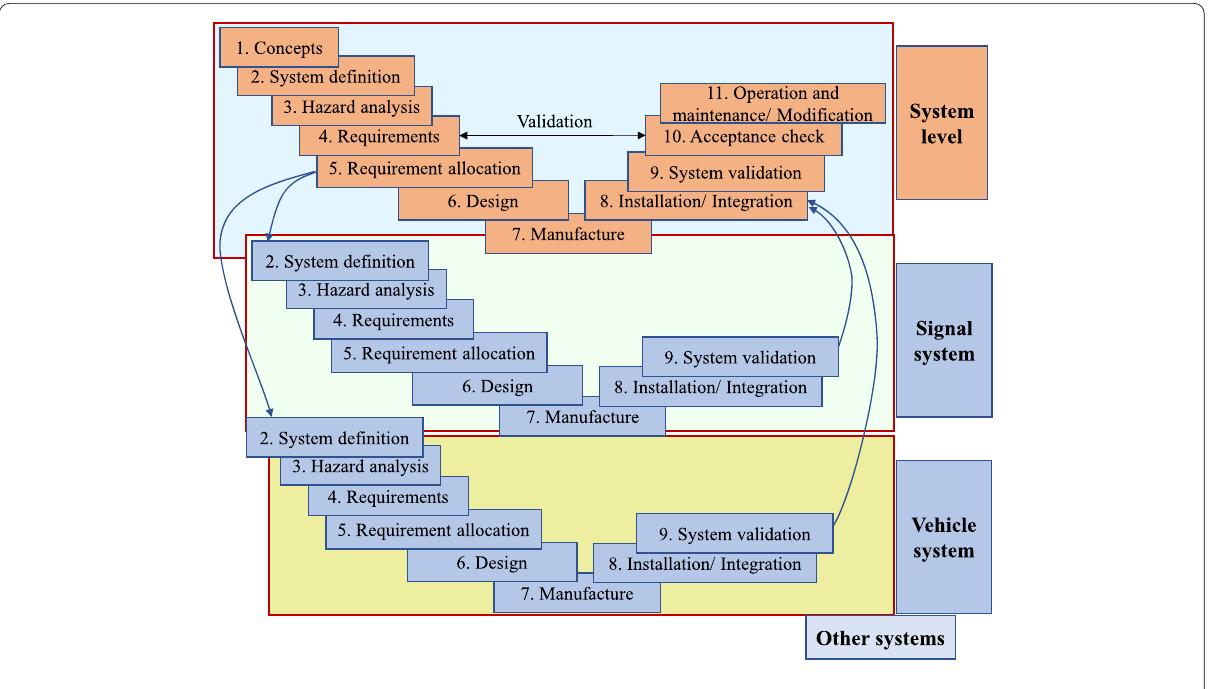
Figure 7 RAMS management activities in different stages of the life